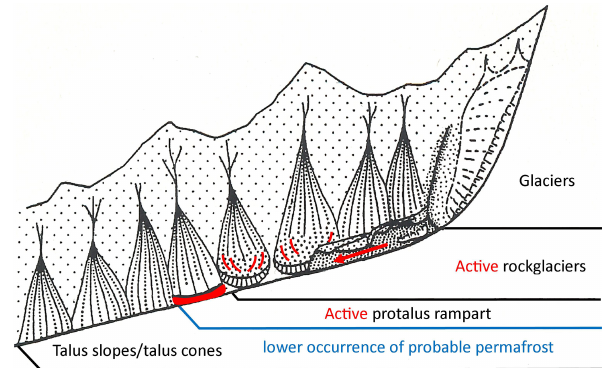
Figure 3. Schematic, hypsometric distribution of mapped land- forms. Red features show active, multiannual creeping structures (furrows, lobes, bulges, ridges) of periglacial landforms indicating the lower occurrence of probable permafrost. Modified from Barsch (1996) after Höllermann